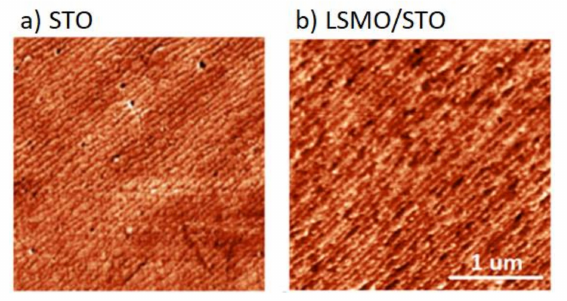
Figure 2. AFM measurement of ( a ) the prepared substrate (using the “bu ff er” method), and ( b ) after the deposition of LSMO using the PLD